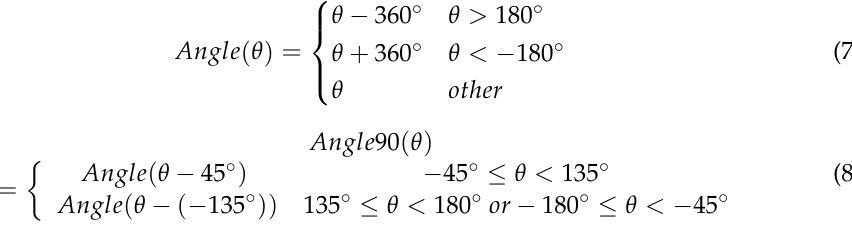
Figure 2. Tapio’s decoupling model of elasticity and the coupling model of polar coordinates pro- posed in this study: ( a ) Tapio’s decoupling model of elasticity. In the figure, R L and R P are the change rates of construction land and population, respectively, and E is the population elasticity of con- struction land. ( b ) Coupling model of polar coordinates. In the figure, PCL and PCL rv are the per- capita construction land area and its ideal value, respectively, and δ is the tolerance coefficient of PL.